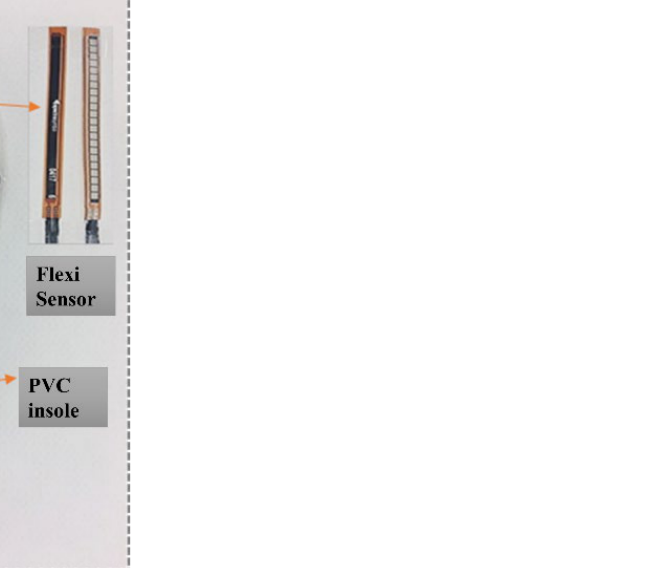
Figure 1. Asymmetric diagram of the encapsulation of the Flexi force and flex sensor on a PVC- based insole.